Question: What form of chart is displayed?
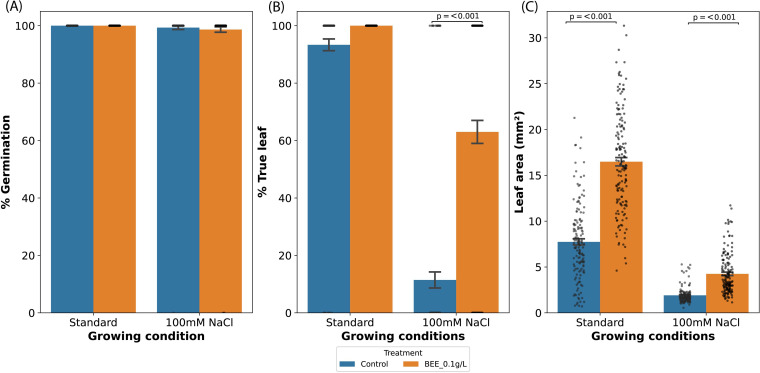
Answer: line